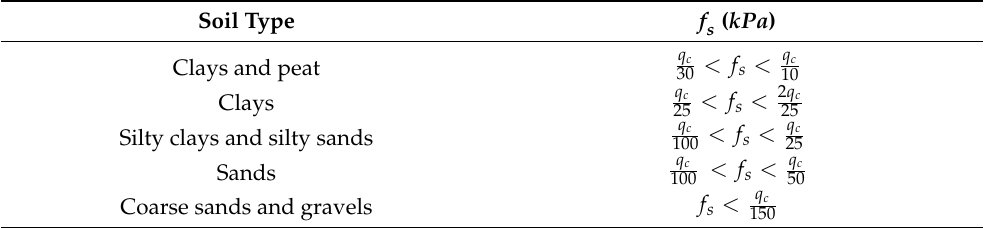
Table 4. Skin friction for various types of